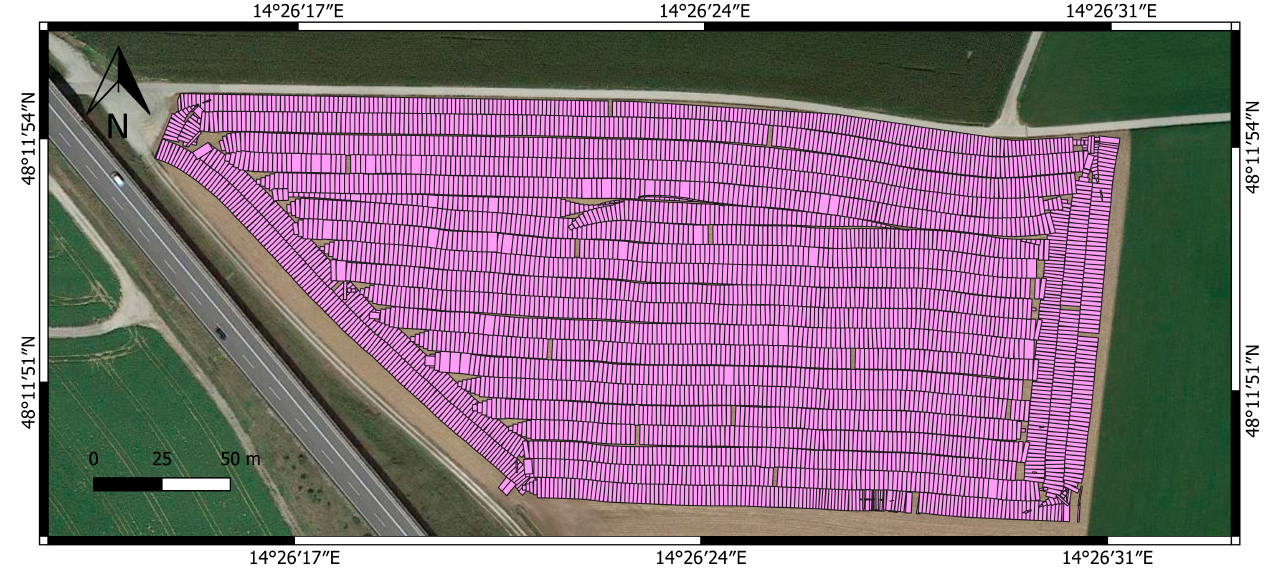
Figure 5. A polygons correspond to the area from which soya was harvested for each single yield